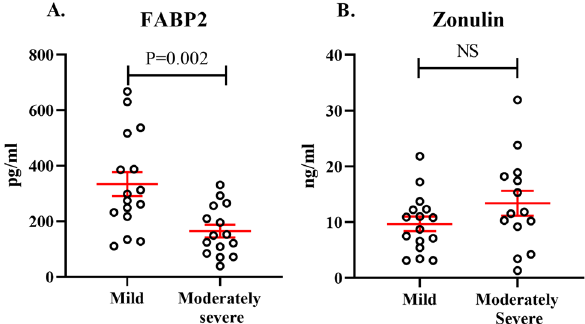
Figure 1. Plasma FABP2 but not zonulin is decreased in patients with more severe COVID-19 compared to patients with milder COVID-19. ( A ) Plasma FABP2 levels in patients with milder ( n = 16) or more severe COVID-19 ( n = 15), respectively. ( B ) Plasma zonulin levels in patients with milder ( n = 16) or more severe ( n = 14) COVID-19, respectively. Student’s t-test used for group comparisons, mean ± SEM indicated with red